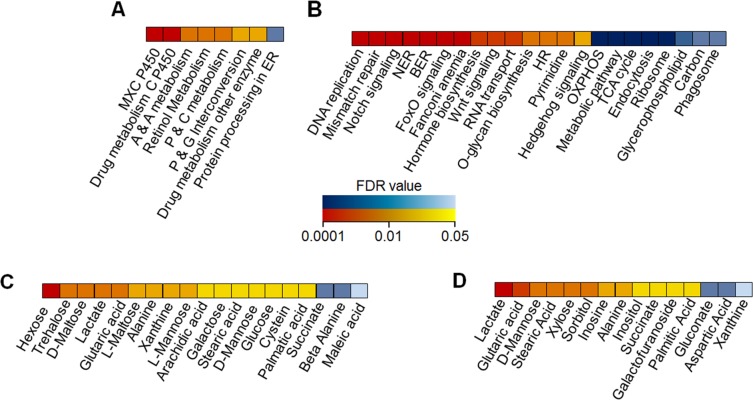
Transcriptomics and metabolomics assays.Differentially expressed KEGG pathways and metabolites from wandering third instar female larvae fed the 1:2 P:C and 1:16 P:C food. Red indicates elevated in Dahomey, blue elevated in Alstonville with darker colours representing smaller FDRs. Detailed FDRs are shown in S3 Table. (A) The differentially expressed KEGG pathways observed in RNA-seq profiling for the 1:2 P:C diet (n = 4 biological rep/mitotype). MXC P450 is Methoxychlor-Cytochrome P450, C P450 is Cytochrome P450, A & A is Ascorbate and Aldarate, P & C is Porphyrin and Chlorophyll, P & G is Pentose and Gluconate, ER is endoplasmic reticulum. (B) The differentially expressed KEGG pathways observed in RNA-seq profiling for the 1:16 P:C diet (n = 4 biological rep/mitotype). NER is nucleotide excision repair, BER is base excision repair, FoxO is Forkhead box, HR is homologous recombination, Pyrimidine is pyrimidine metabolism, OXPHOS is oxidative phosphorylation, TCA is tricarboxylic acid, Glycerophospholipid is glycerophospholipid metabolism, and Carbon is carbon metabolism. Detailed FDRs are shown in S5 Table. (C) Differentially abundant metabolites observed in GC/MS profiling (n = 5 biological rep/mitotype) for the 1:2 P:C diet. (D) Differentially abundant metabolites observed in GC/MS profiling (n = 5 biological rep/mitotype) for the 1:16 P:C diet.